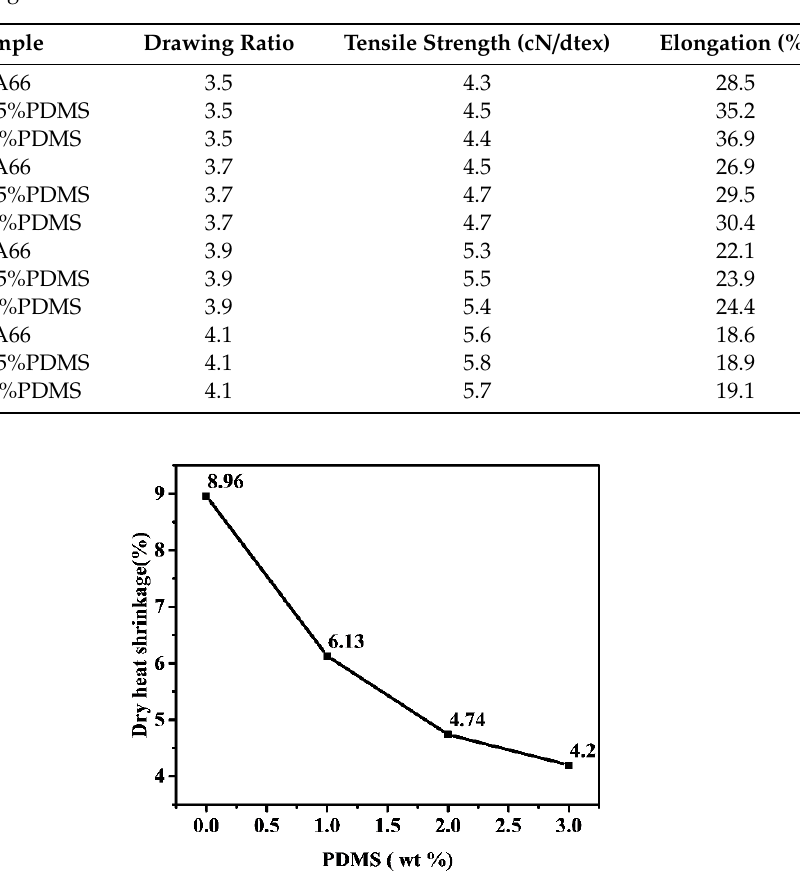
Table 1. Tensile strength and elongation of PA66 / PDMS blend fibers with di ff erent addition of PDMS at varied drawing ratio.